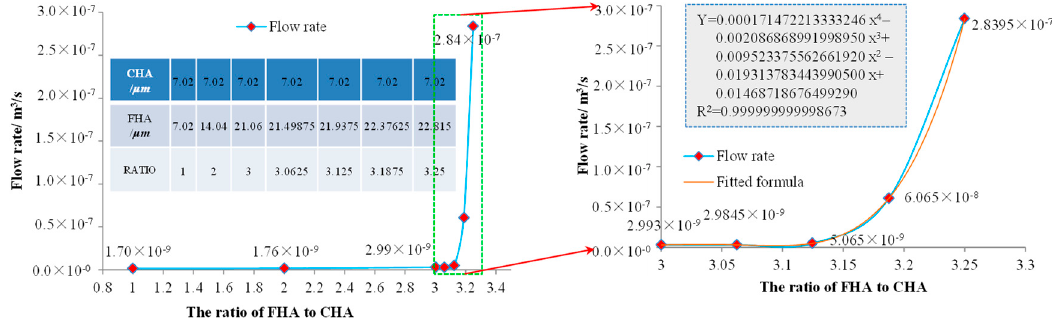
Figure 10. Flow rate change curves of the fitting model.